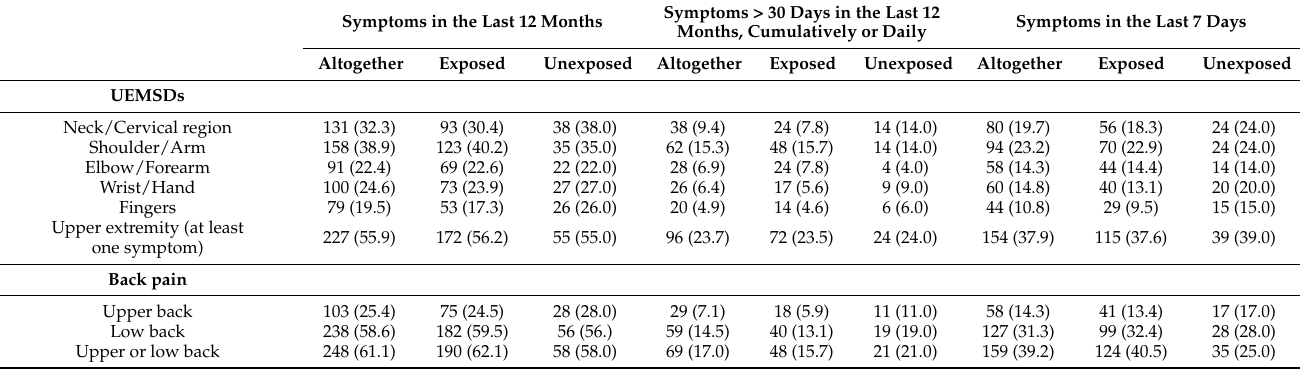
Table 2. Frequency of musculoskeletal symptoms experienced by study subjects in the upper- extremity and back areas (number of subjects (%)). Abbreviations: UEMSDs: upper extremity musculoskeletal disorders.